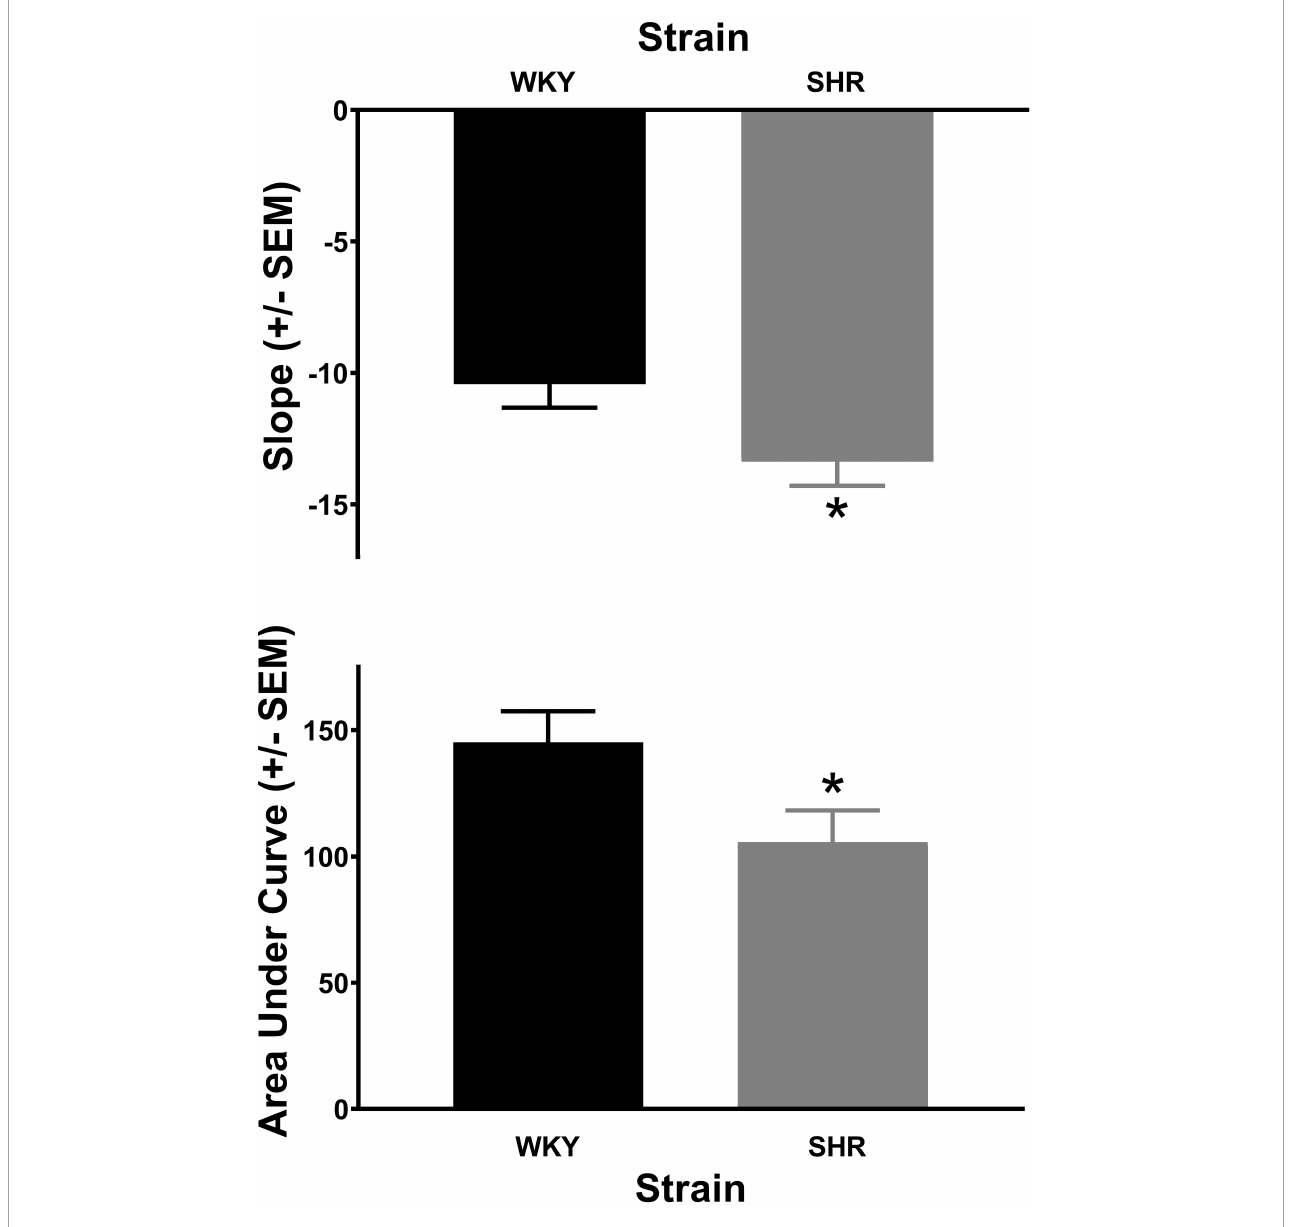
FIGURE2 The slope of the discounting curve (top) was significantly more negative for the spontaneously hypertensive rat (SHR) versus WKY rats, while the area under the discounting curve (bottom) was significantly less for the SHR versus WKY rats, * p < 0.05. The trial lengths were the same regardless of which lever was